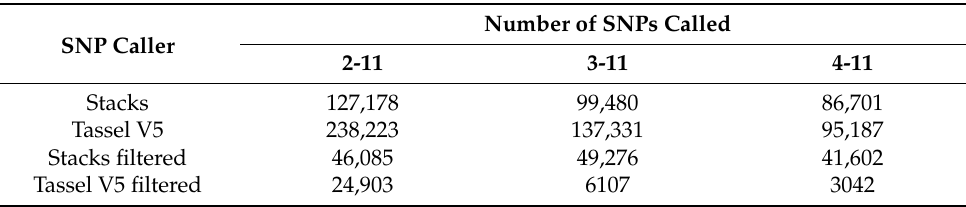
Table 1. Number of SNPs identified for three hybrid populations (2-11, 3-11, and 4-11) using two different SNP callers with and without